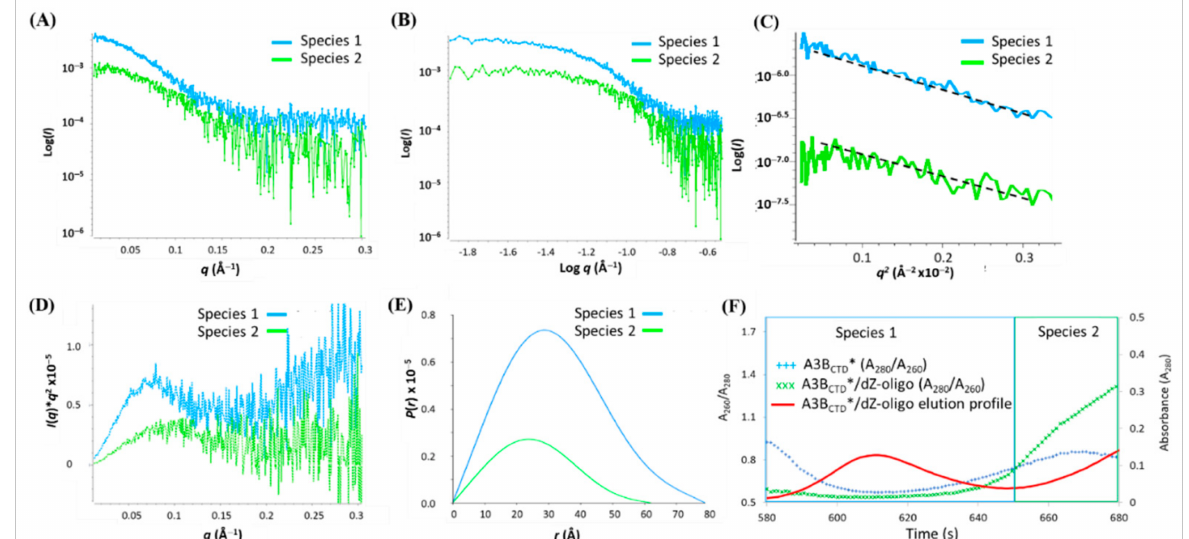
Figure 13. SAXS analysis of the A3B CTD * dimer/dZ-oligo deconvoluted species. ( A ) 1D-scattering curves of each species. ( B ) Double log plots. ( C ) Guinier plots. ( D ) Kratky plots. ( E ) P ( r ) distribution plots. ( F ) Plots of the absorbance ratio A 280 /A 260 to assess presence of ssDNA during elution of the A3B CTD */dZ-oligo sample. The red line is the elution profile of the A3B CTD */dZ-oligo sample and the green crosses the A 280 /A 260 ratio. The blue crosses are ligand-free A3B CTD * (vide supra). Experiments were conducted using 2.5 mg/mL of A3B CTD * dimer with dZ-oligo at a 1 to 10 ratio in pH 5.5 buffer (see caption to Figure